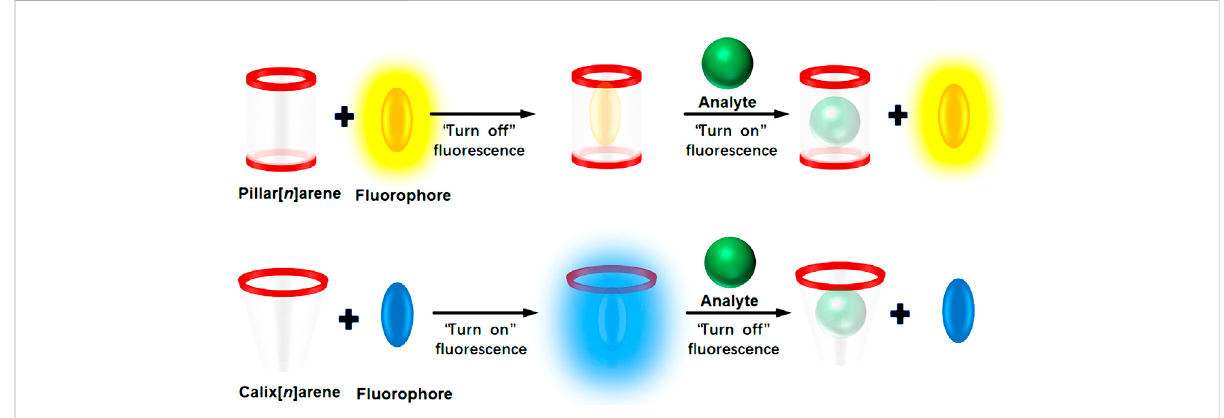
FIGURE 1 CartoondepictionofanF-IDAwhichinvolvesanintegratedhost- fl uorophoresensorthatdisassemblesinthepresenceofananalytetoproduce a turn-on or turn-off fl uorescence response.